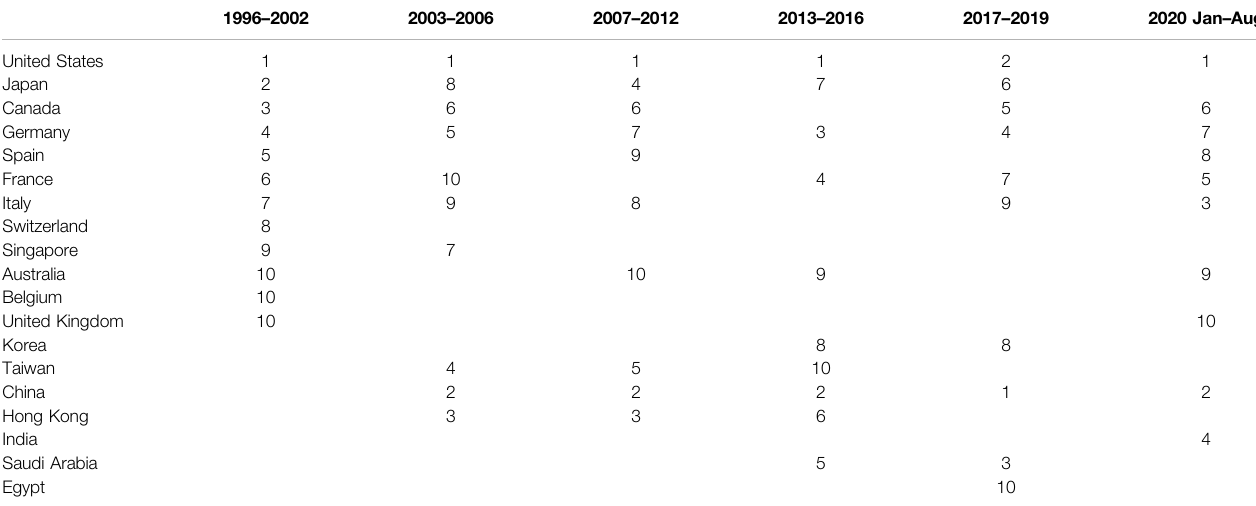
TABLE 3 | Top 10 countries for coronavirus articles in each